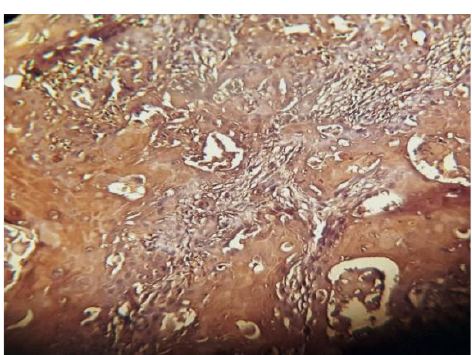
Figure4: Strong staining(Score3 in SIS) of Ang-2 expression of the studied samples